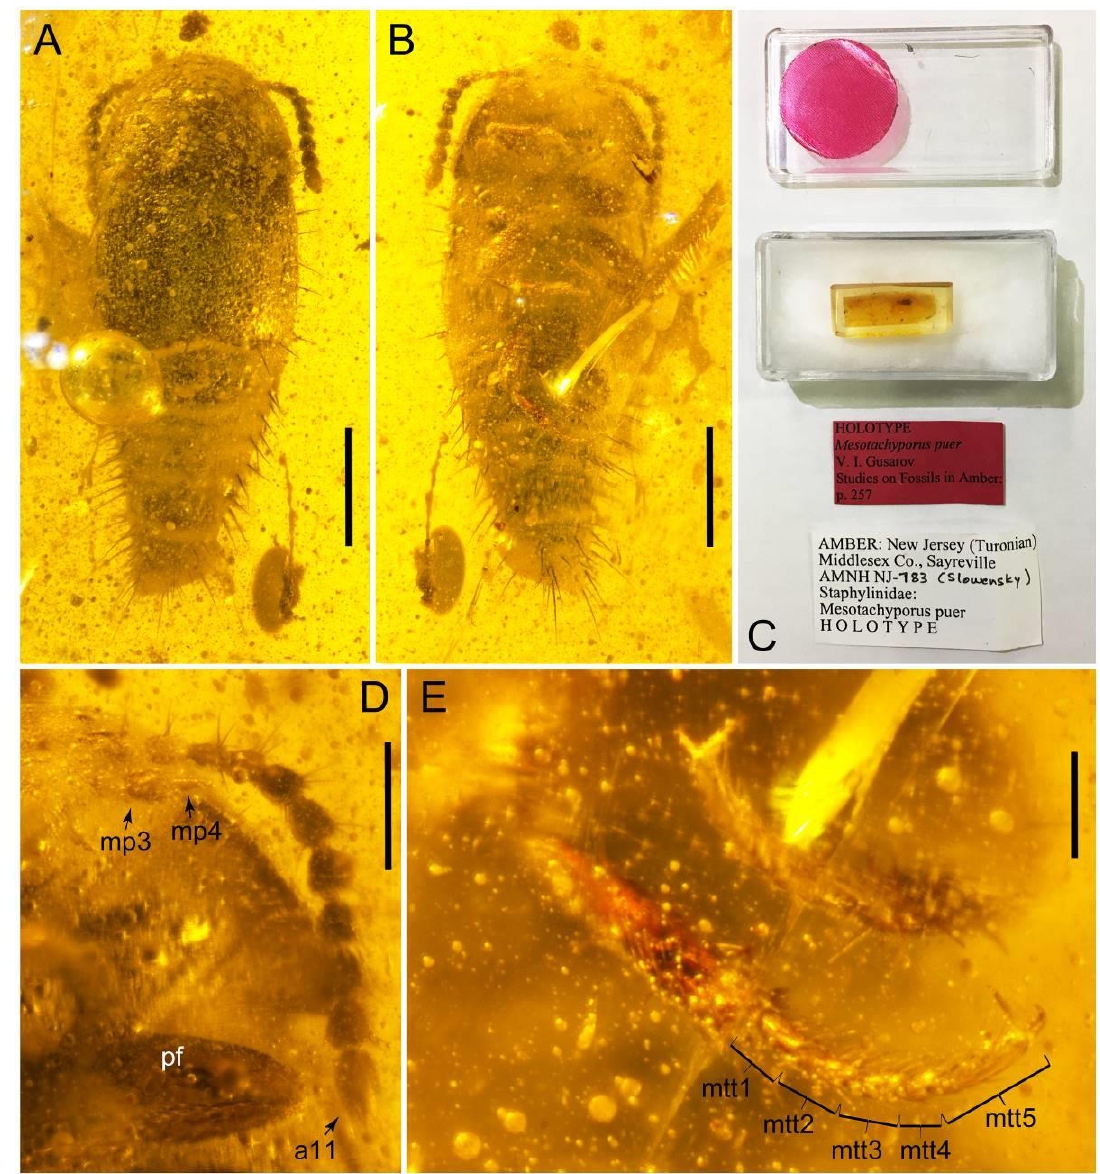
Figure 13. Photographs of Tachyporini: Tachyporina [† Tachyporus puer (Gusarov) (= † Mesotachyporus puer Gusarov) in Upper Cretaceous (Turonian) New Jersey amber, holotype, AMNH NJ-783]. ( A ) habitus, dorsal view. ( B ) habitus, ventral view. ( C ) specimen with its data labels. ( D ) antenna, maxillary palpus, and foreleg, ventral view. ( E ) metatarsus. Scale bars: 0.5 mm ( A , B ); 0.2 mm ( D ); 0.1 mm ( E ). Abbreviations: a11, antennomere 11; mp3–4, maxillary palpomere 3–4; mtt1–5, metatarsomere 1–5; pf, profemur. Photo credits: David Grimaldi ( A , B , D , E , all used with